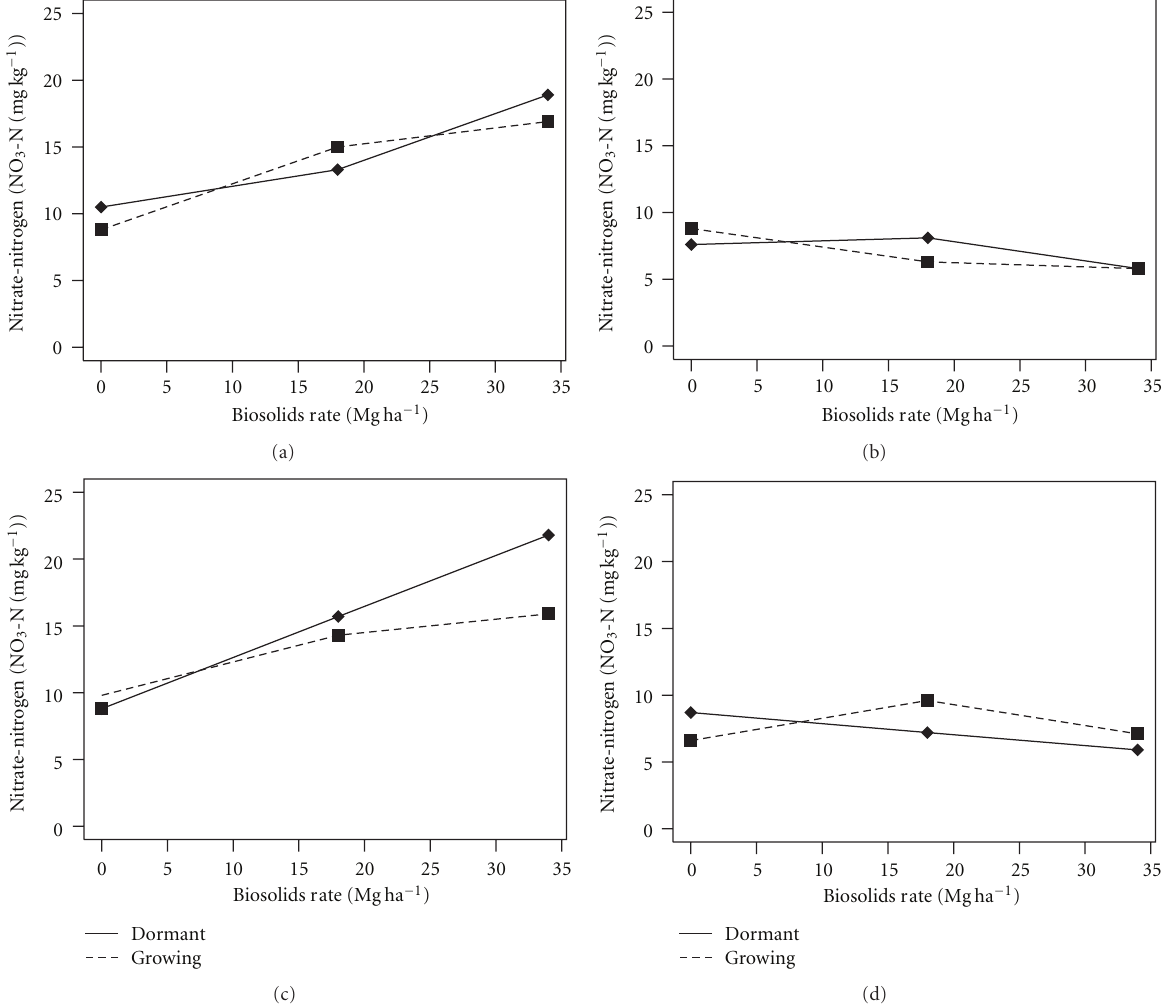
Figure 9: Soil nitrate nitrogen as a ff ected by biosolids application, season of application, mulch type (biosolids or inert mulch), and irrigation. Biosolids were applied in 1998. (a) Nonirrigated plots treated with biosolids, (b) irrigated plots treated with biosolids; (c) nonirrigated plots treated with inert mulch, and (d) irrigated plots treated with inert mulch. Solid lines represent dormant season application; dashed lines represent growing season application (redrawn from